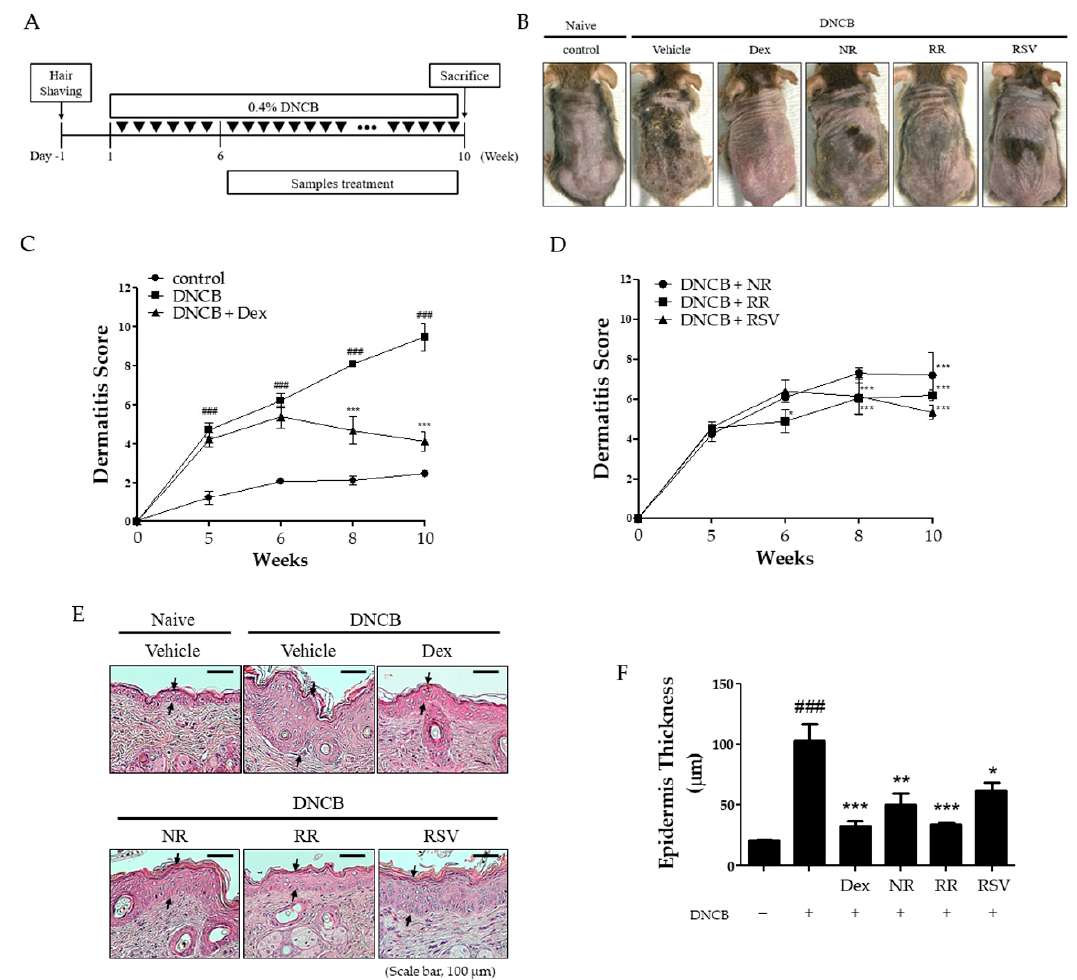
Figure 1. Effect of RR on the development of atopic dermatitis (AD) in DNCB-induced NC/Nga mice. ( A ) Schematic presentation of the animal experiment schedule. Mice were divided into five groups ( n = 7 per group). After the induction of AD-like symptoms with DNCB, NR, RR, and RSV were topically applied thrice weekly for five weeks. ( B ) Images of dorsal skin were taken on the last day of the experiment. ( C , D ) The dermatitis score was defined as the sum of score for five clinical indexes: erythema, edema, erosion, dryness, and lichenification. ( E ) Hematoxylin and eosin staining of dorsal skin. Scale bar = 100 µ m. Arrows indicate the thickness of epidermis. ( F ) Histogram of hematoxylin and eosin staining. Values are expressed as means ± SEM. ### p < 0.001 versus vehicle group; * p < 0.05, ** p < 0.01, and *** p < 0.001 versus DNCB-treated group. Dex, dexamethasone; NR, normal rice; RR, resveratrol-enriched rice; RSV, resveratrol.